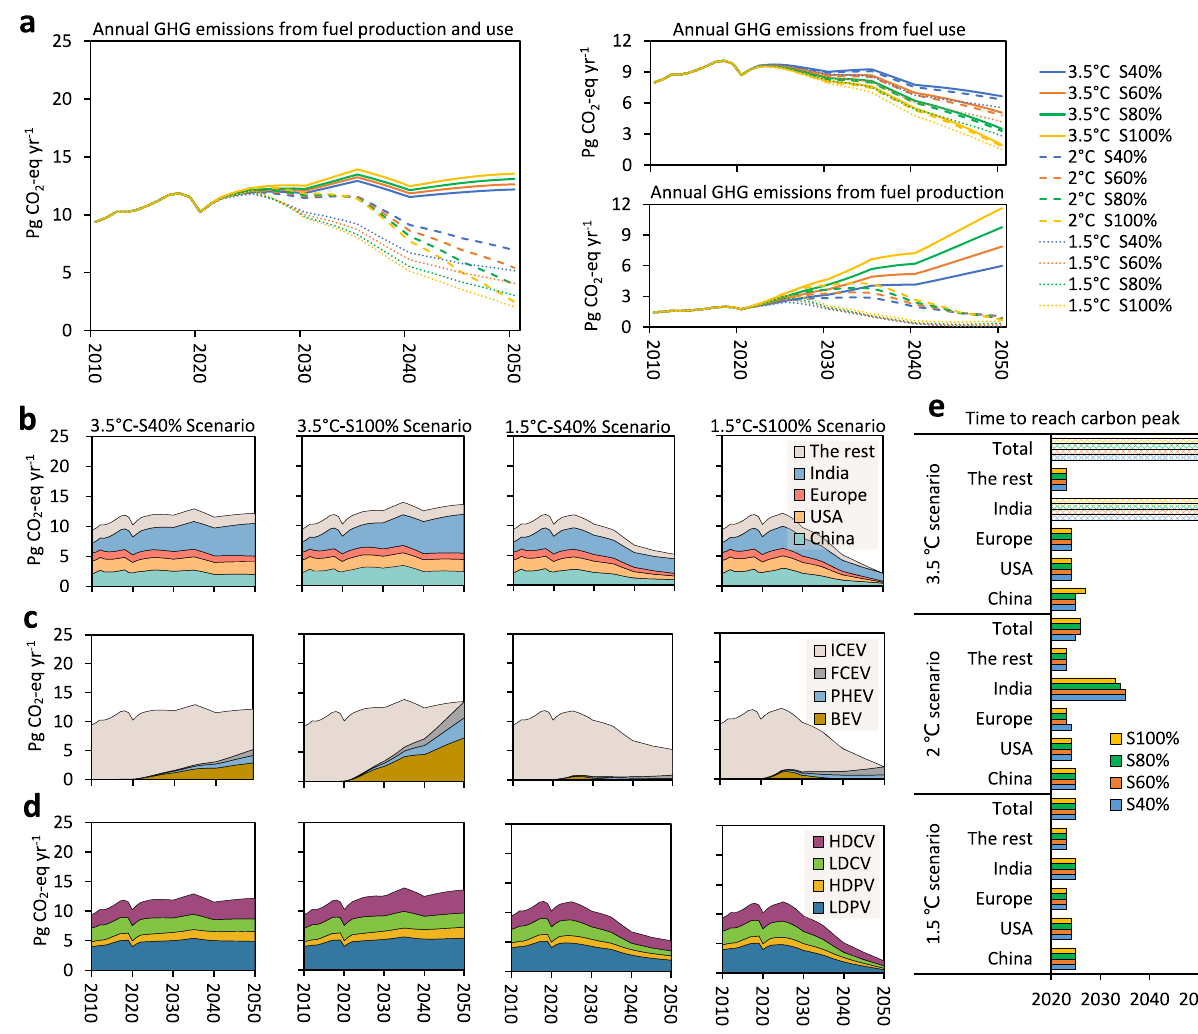
Fig. 4 | Comparison of annual road transportation fuel greenhouse gas emis- sions. a Annual greenhouse gas (GHG) emissions (Pg CO 2 -eq yr − 1 ) from fuel pro- ductionanduseinthe48countiesacrossfourEVpenetrationscenarios(40 – 100%) under three energy transition scenarios (1.5 – 3.5°C).The results for 2010 – 2020are historical statistics; the results for 2021 – 2050 are projected. b Country-wise breakdownofannualGHGemissions. c Powertrain-wisebreakdownofannualGHG emissions. d Sector-wise breakdown of annual GHG emissions. Results for the